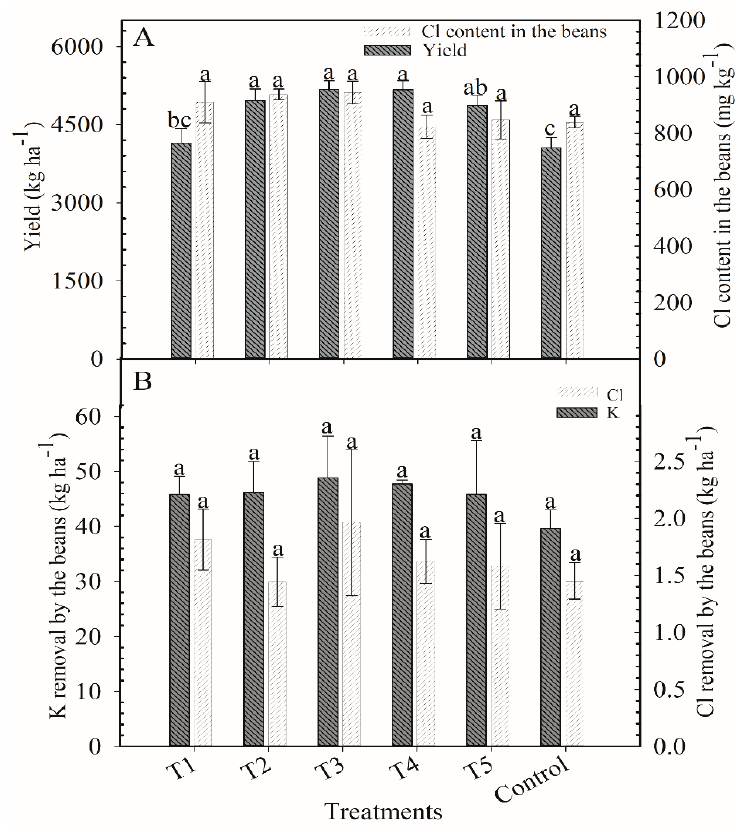
Figure 6. Yield ( A ), Cl content in the beans ( A ), and removal of K and Cl ( B ) by the beans of coffee at cherry stage after application of blends of KCl e K 2 SO 4 as cover fertilization. Harvest of 2019/2020. Means followed by the same letter in the column do not differ according to Tukey’s test ( p < 0.05). Vertical bars indicate the standard error of the mean ( n = 4). T1: 100% KCl; T2: 75% KCl + 25% K 2 SO 4 ; T3: 50% KCl + 50% K 2 SO 4 ; T4: 25% KCl + 75% K 2 SO 4 ; T5: 100% K 2 SO 4 ; control did not receive K 2 O.